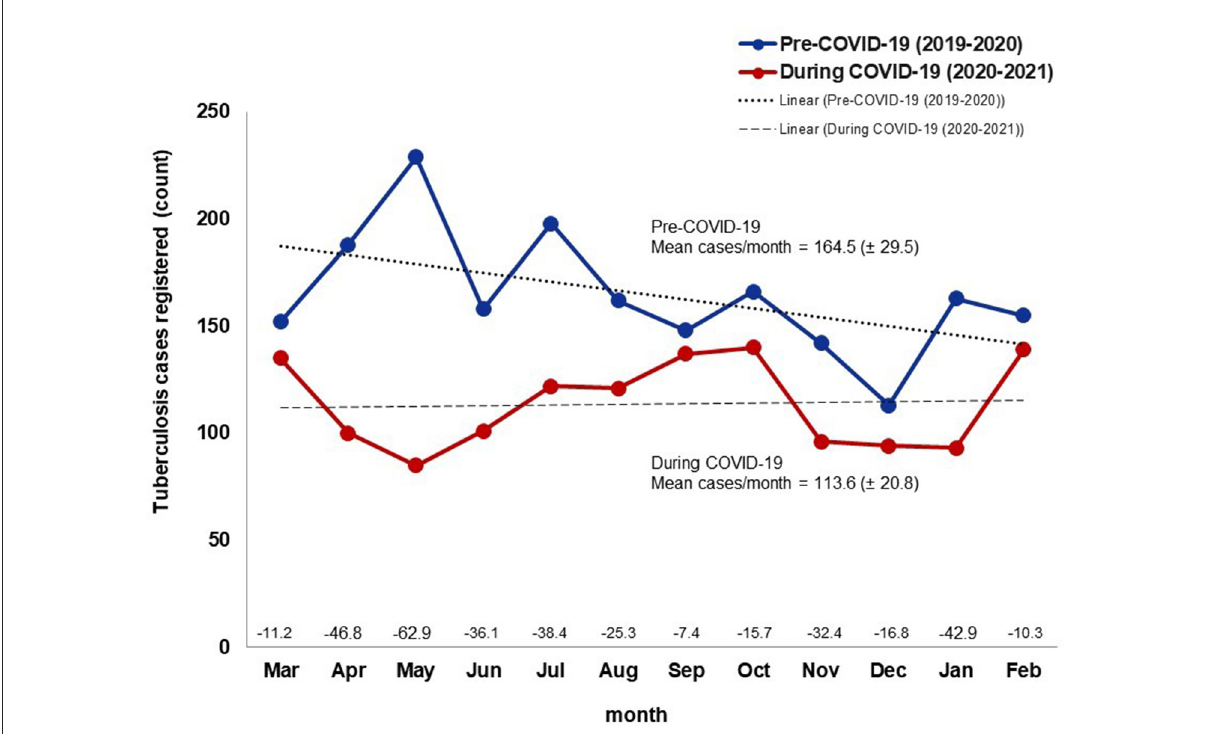
FIGURE2 Tuberculosis cases registered by month in the year before and the first year during the COVID-19 pandemic, Baja California, México, 2019–2021. Data source: Mexico Ministry of Health management information system